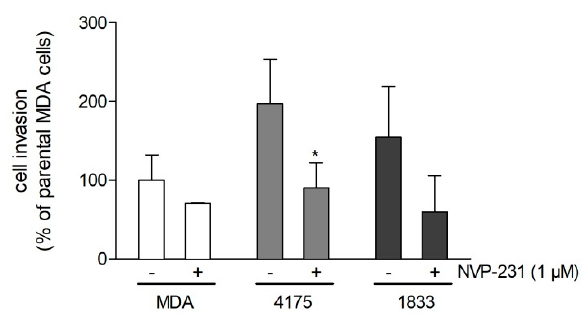
Figure 3. Effect of the CerK inhibitor NVP-231 on cell invasion of parental and metastatic MDA-MB-231 cells. 5 × 10 4 parental MDA-MB-231 cells (open columns), lung metastatic (4175, grey columns), and bone metastatic (1833, black columns) cells were seeded onto Matrigel-coated transwell filters and treated for 48 h in the absence ( − ) or the presence (+) of NVP-231 (1 μ M) in DMEM/1% FBS. Invaded cells were determined as described in the Methods section. Representative images are shown in supplementary Figure S4. Data are expressed as percentage of parental MDA cells and are means ± SD ( n = 3). * p < 0.05 compared to vehicle-treated 4175 cells. To verify that the anti-migratory effect of pharmacological inhibition of CerK can be reproduced by a genetic approach, we stably downregulated CerK expression in the 4175 and the 1833 sublines by lentiviral transduction using a CerK-directed small hairpin RNA (shRNA)